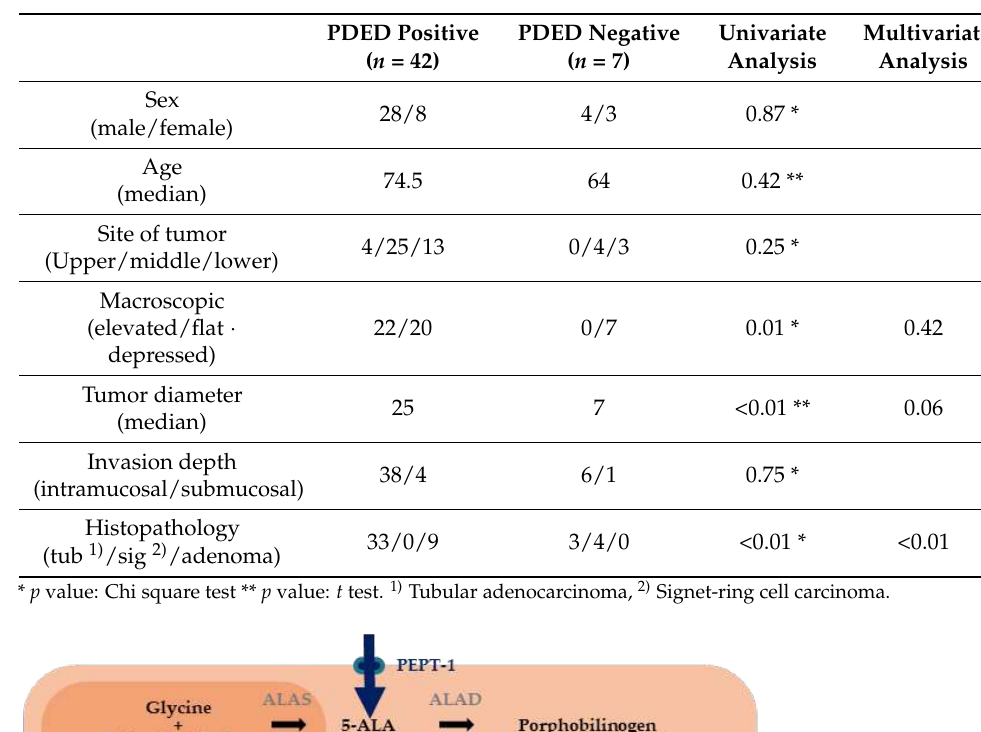
Table 1. Comparison of clinicopathological features between PDED positive and negative groups.